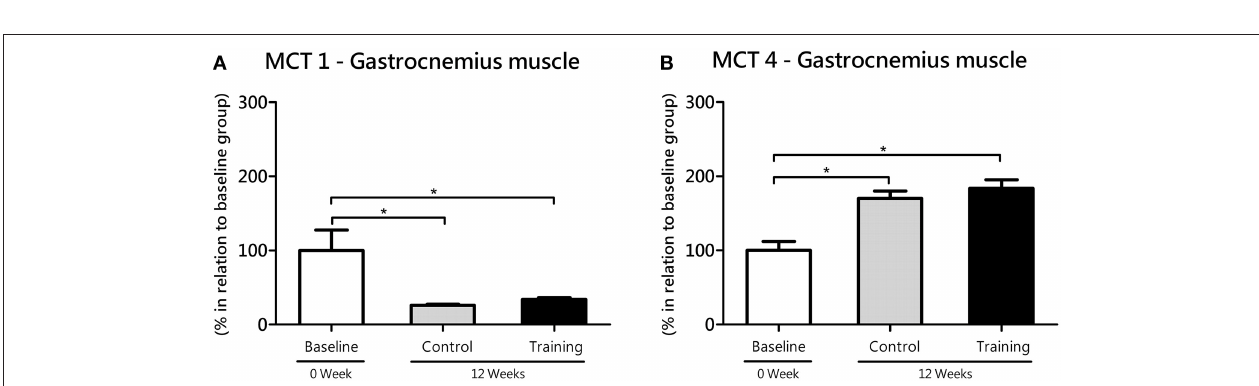
FIGURE 4 | mRNA level of monocarboxylate transporters (MCT) 1 (A) and 4 (B) in the soleus (oxidative) muscle for the control and training exercise groups. The data (mean ± SEM) are relative (%) to baseline group, which has been set at 100%. Newman-Keuls post hoc test was used to locate group’s difference. N = 7 –10 rats per group. Sig. diff. * P < 0.05 .